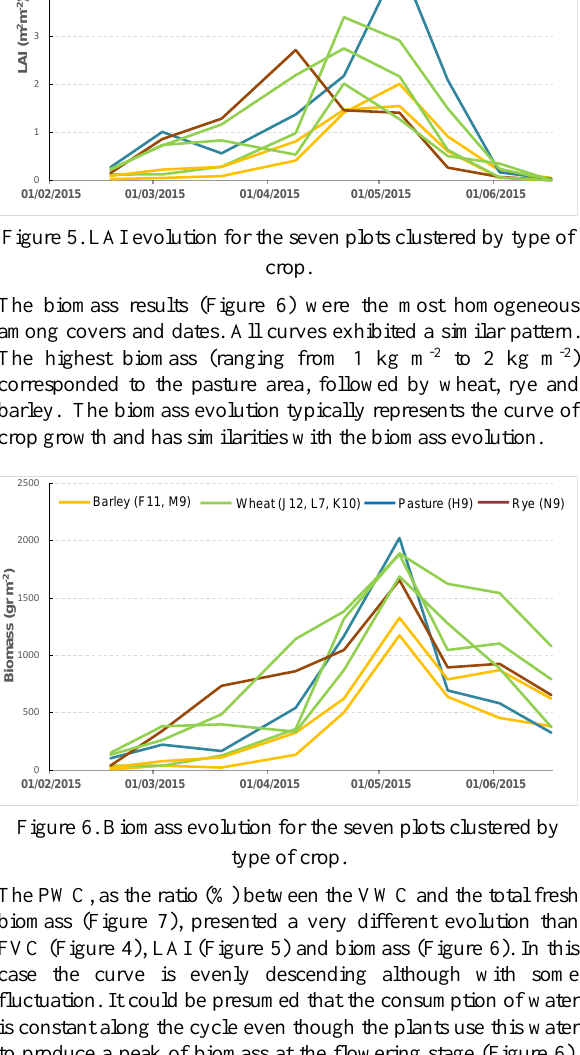
Figure 3. Height evolution for the seven plots clustered by type of crop.